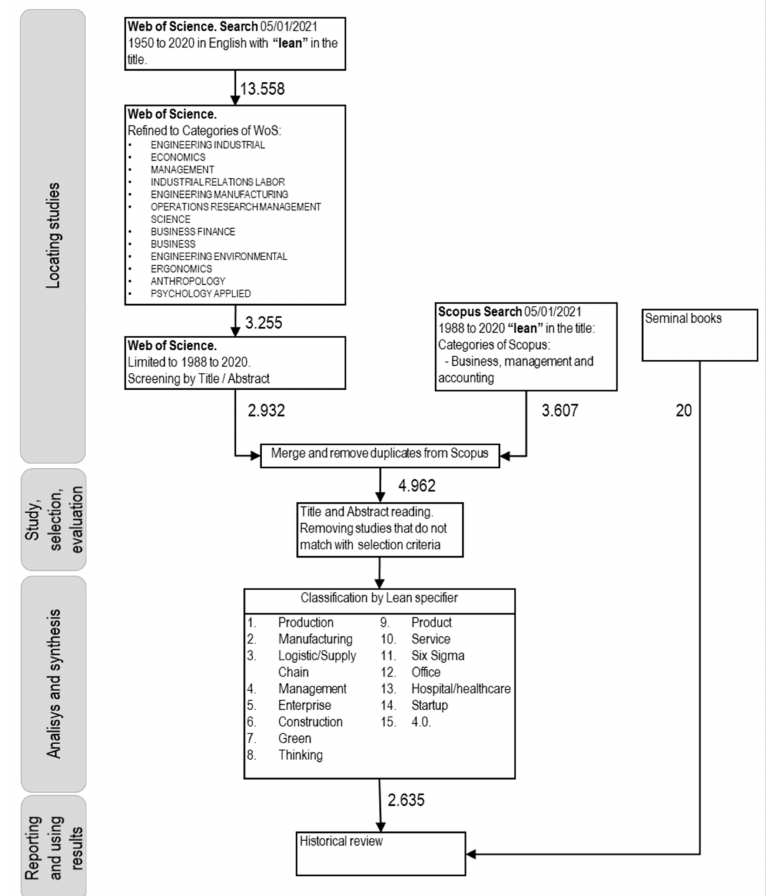
Figure 3. SLR process